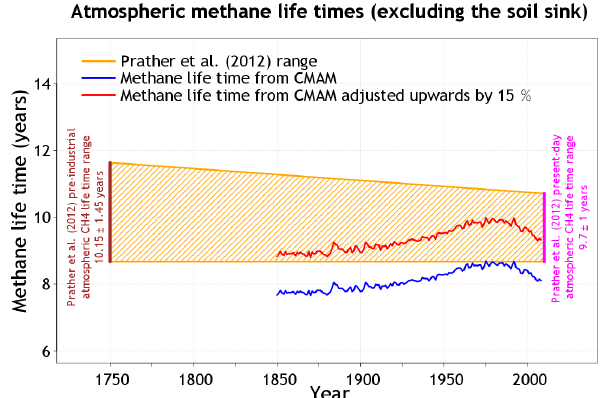
Figure 2. Comparison of atmospheric methane lifetime obtained from the Canadian Middle Atmosphere Model (CMAM) for the pe- riod 1850–2010 with observation-based estimates from Prather et al. (2012) but excluding the soil sink as explained in Sect.